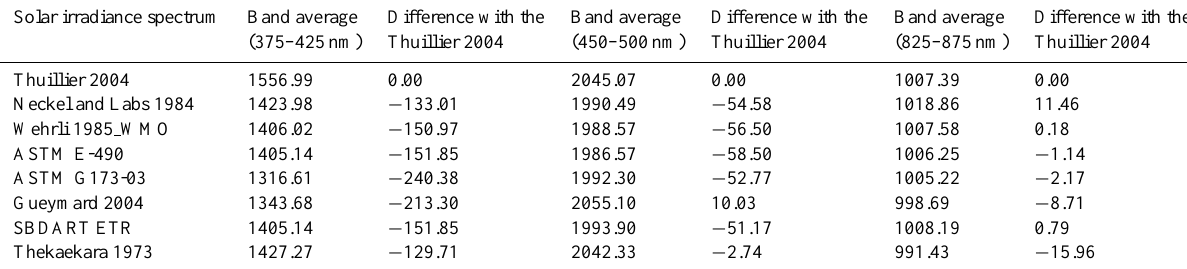
Table 4. The band-averaged values and their differences with the Thuillier 2004 spectrum. Solar irradiance spectrum Difference with